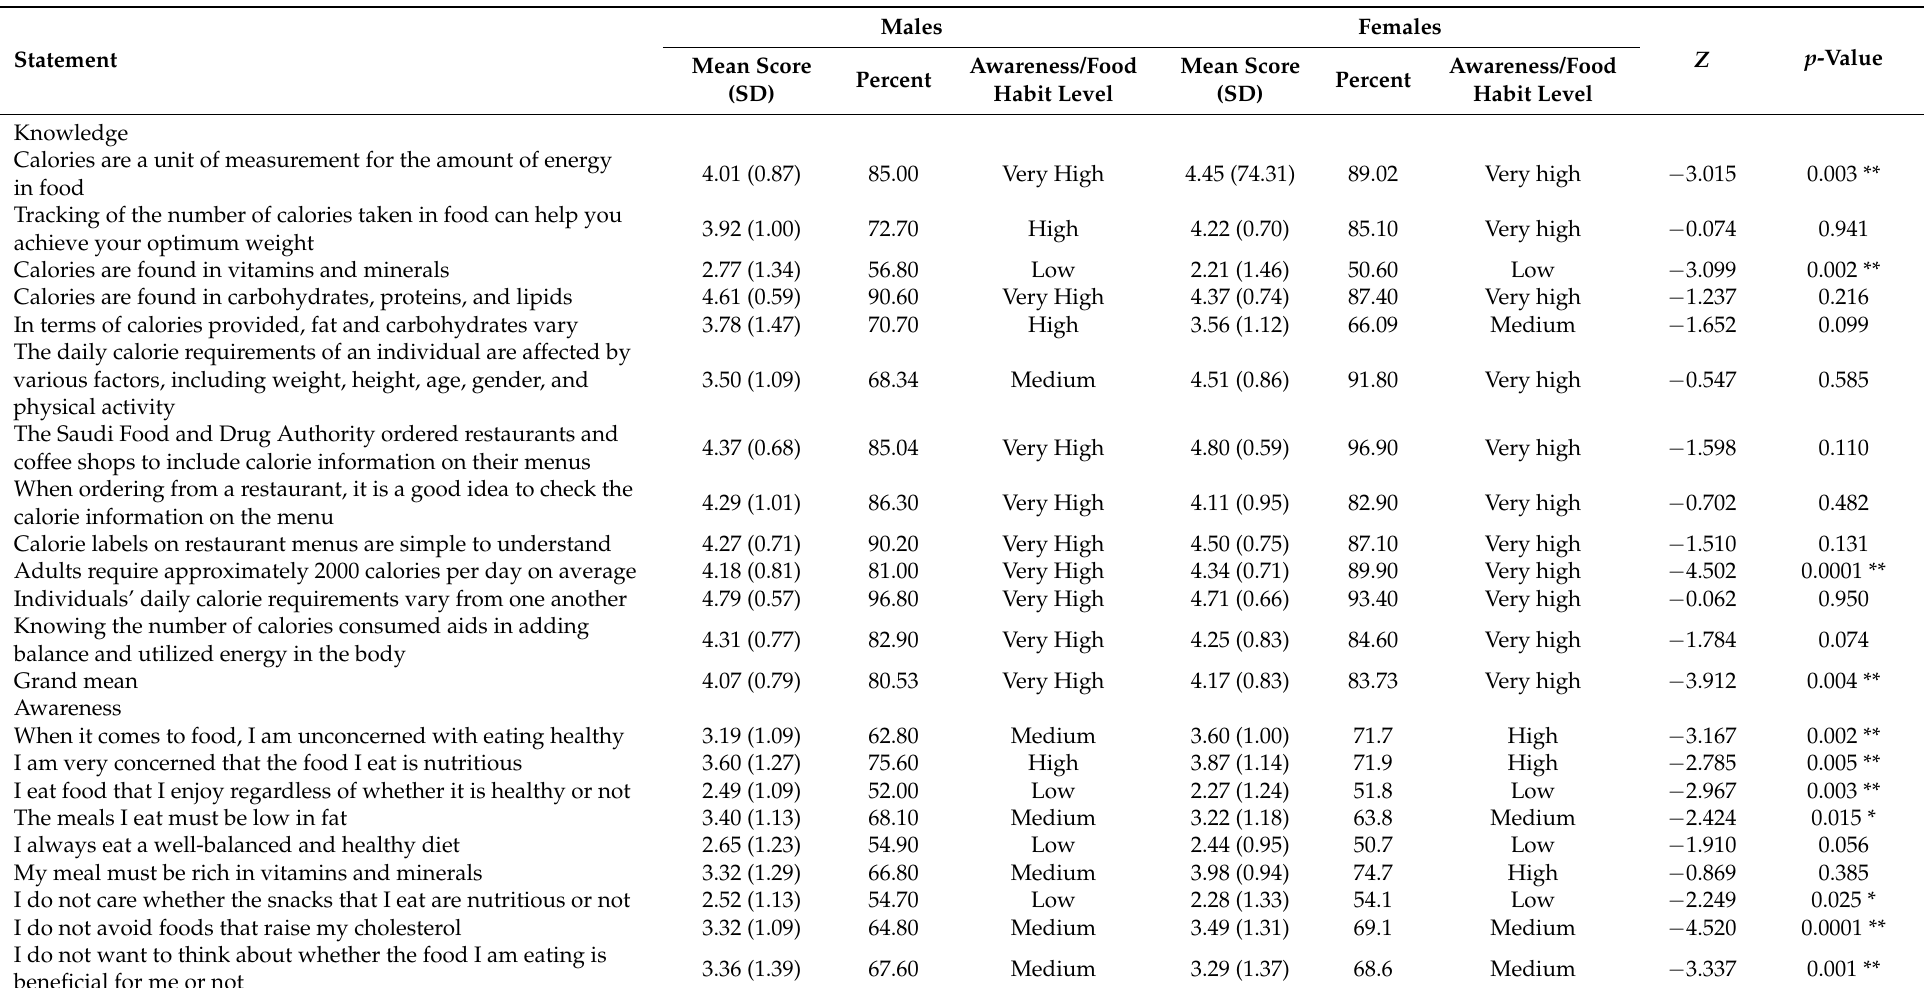
Table 3. The effect of calorie labeling on knowledge and awareness of Male ( n = 360) and Female ( n = 442) respondents according to the Likert